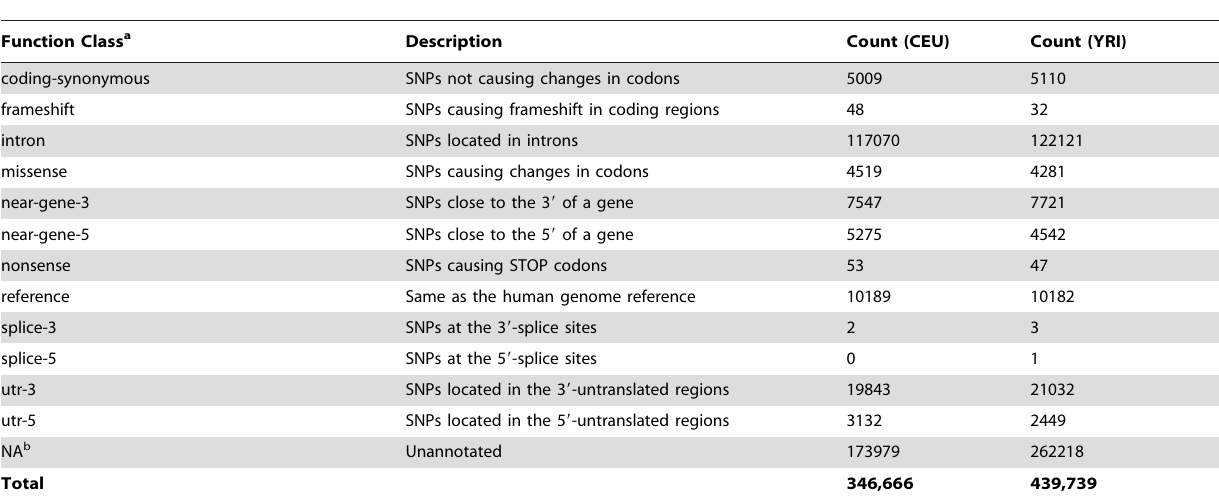
Table 1. Functional annotations of common SNPs in the exon